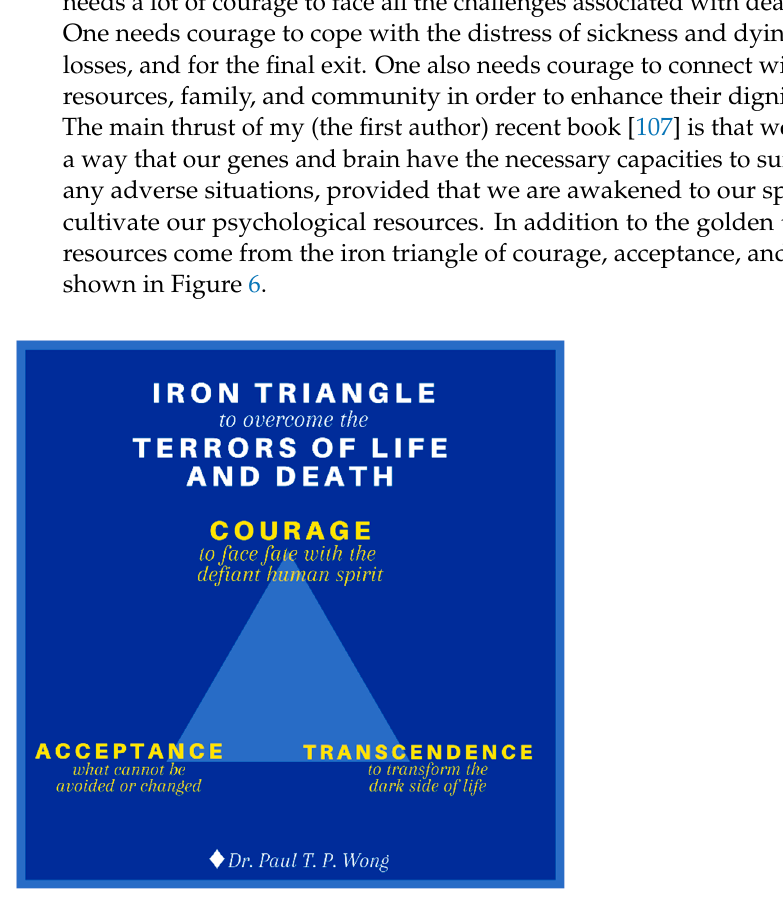
Figure 6. The Iron Triangle.